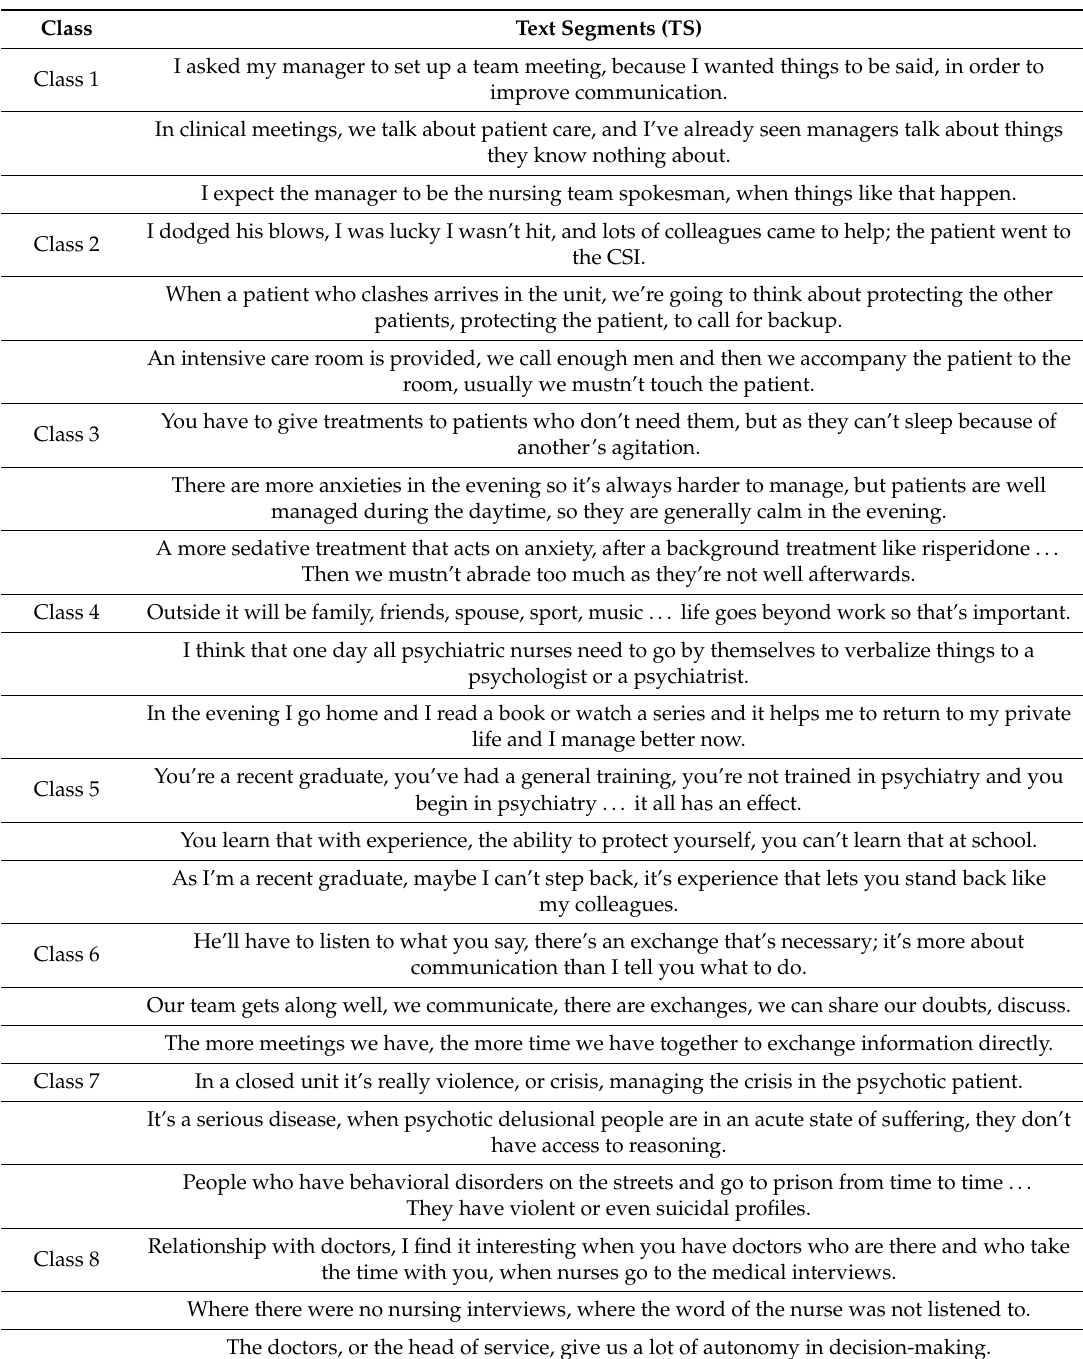
Table 2. Sample of specific text segments classified by